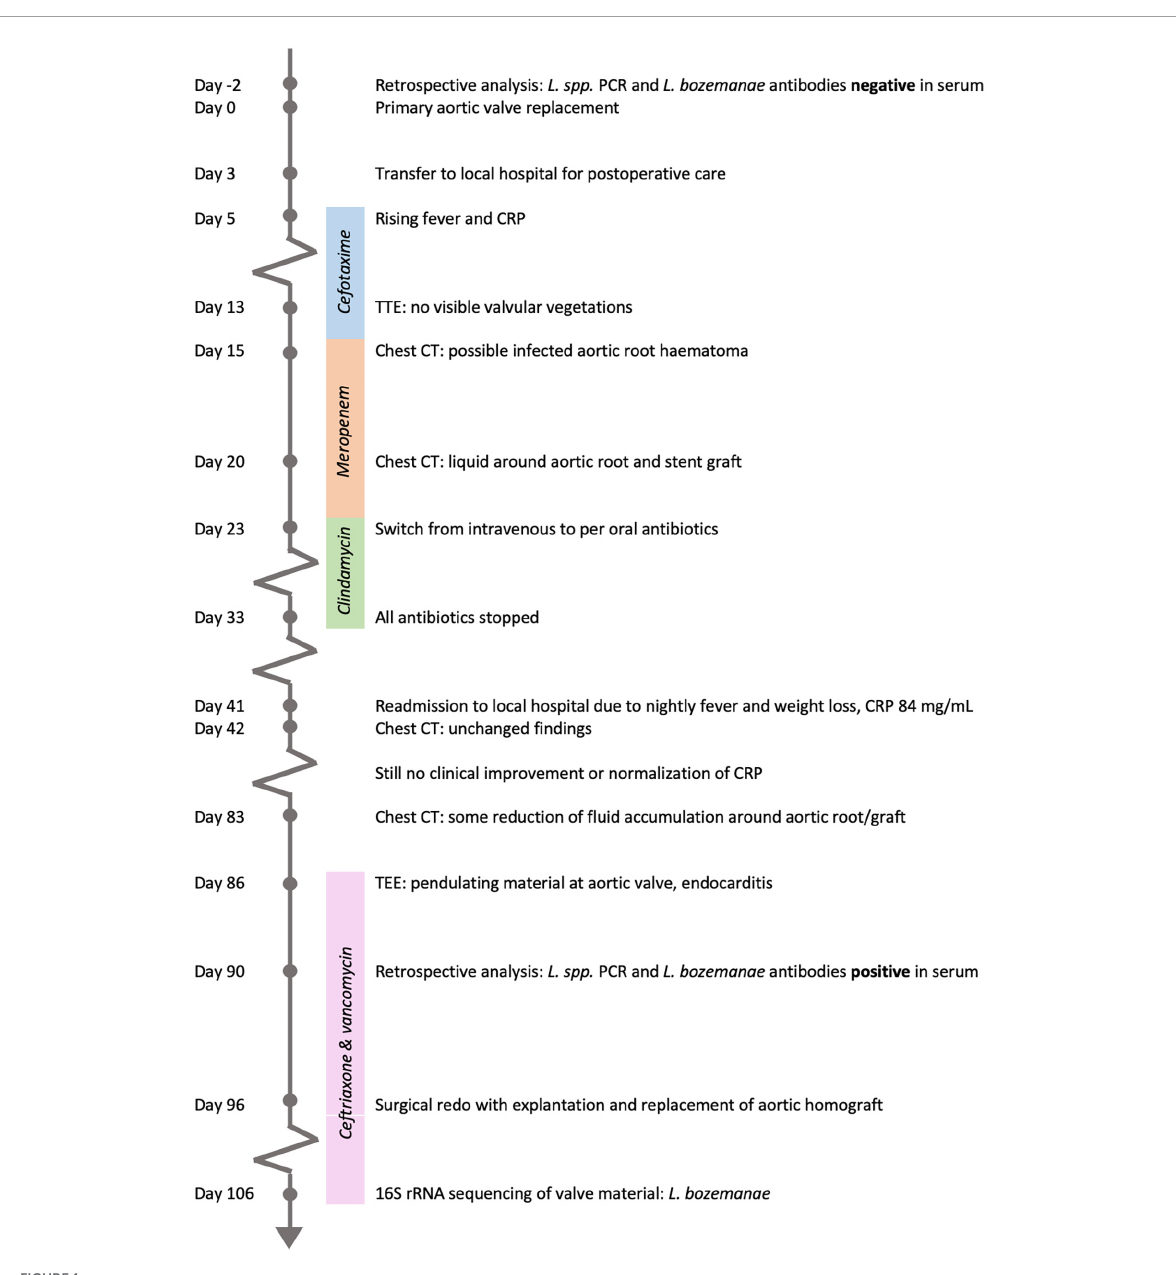
L. bozemanae antibodies, while in serum from Day 90 the titer was positive ( >